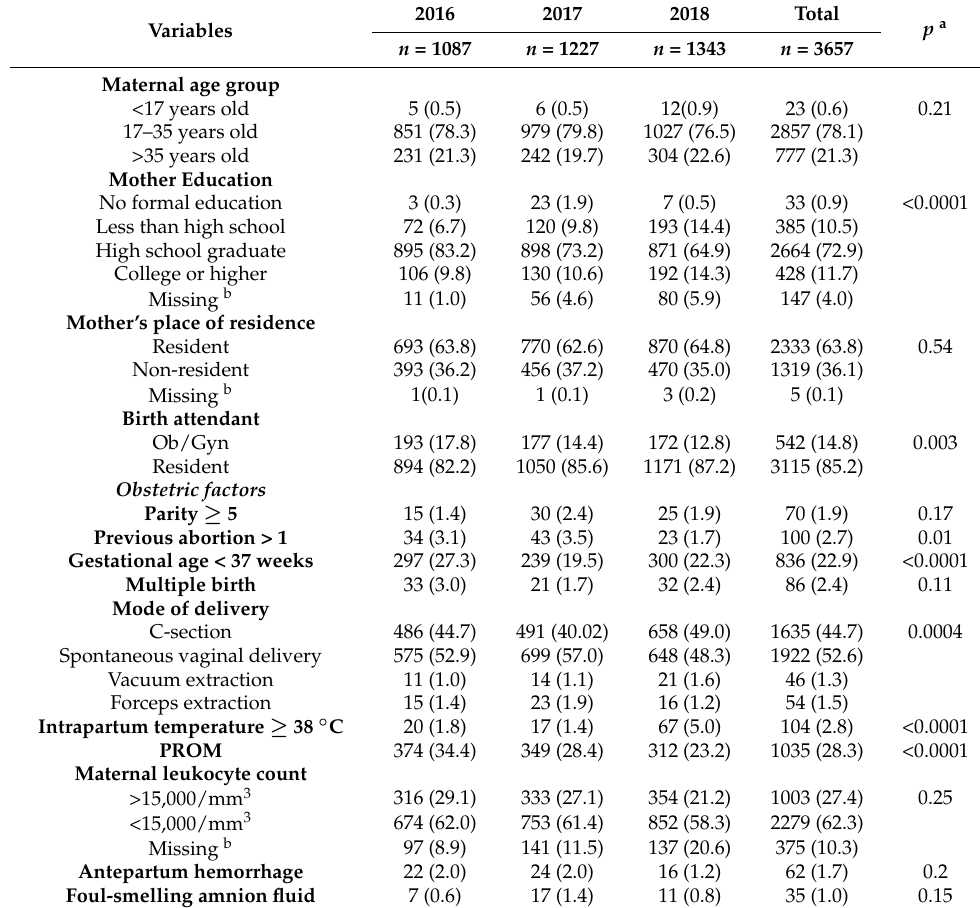
Table 1. Maternal sociodemographic and obstetric characteristics across study